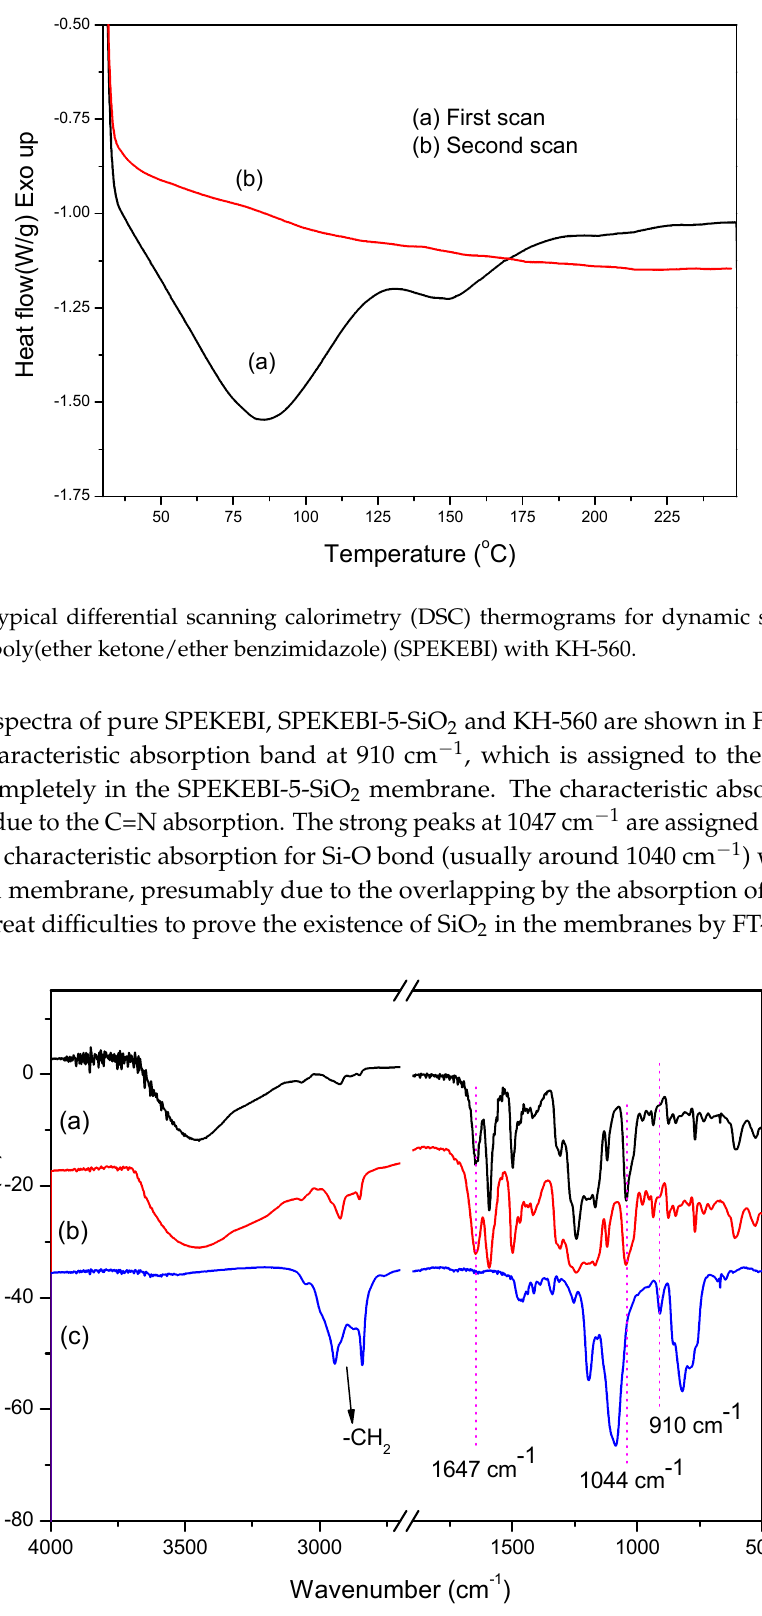
Figure 2. Fourier transform infrared (FT-IR) spectra of SPEKEBI ( a ), SPEKEBI/KH-560-5% ( b ) and KH-560 ( c ).